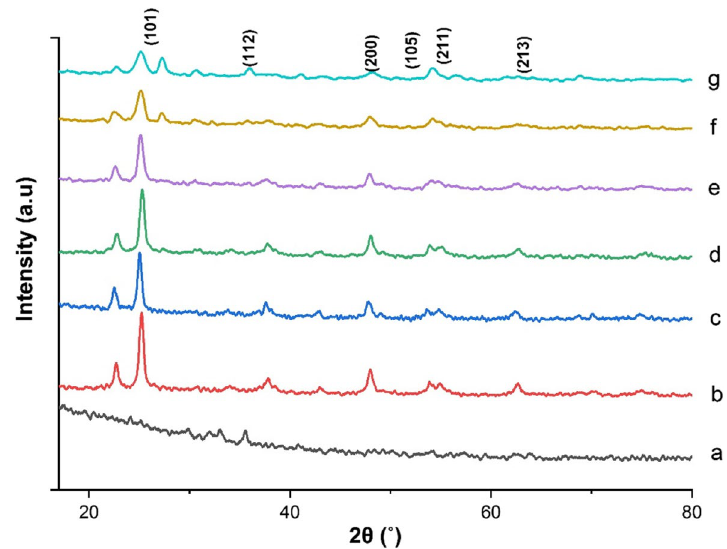
Fig. 5 X-ray diffraction patterns of a Fe 2 O 3 , b TiO 2 , c TiO 2 –Fe(1:0.05), d TiO 2 –Fe(1:0.1), e TiO 2 –Fe(1:0.2), f TiO 2 – Fe(1:0.5), and g TiO 2 –Fe(1:1)